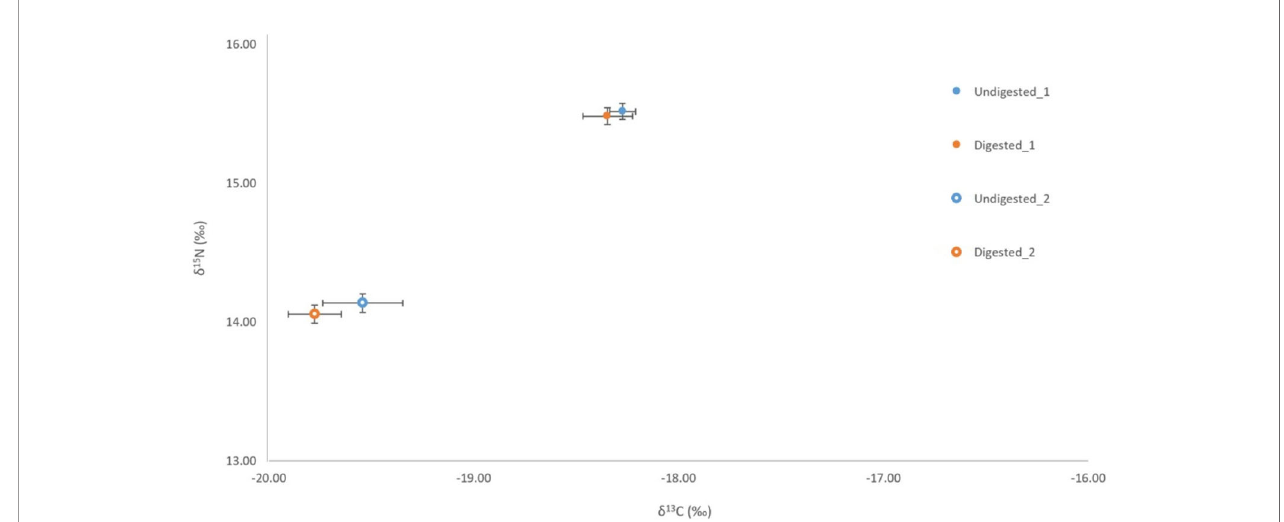
FIGURE 3 | Comparison of d 13 C and d 15 N signatures for undigested (penguin 1 n = 6, penguin 2 n =6) and digested (penguin 1 n = 3, penguin 2 n =3) feathers of little penguins consumed by captive Australian and long-nosed fur